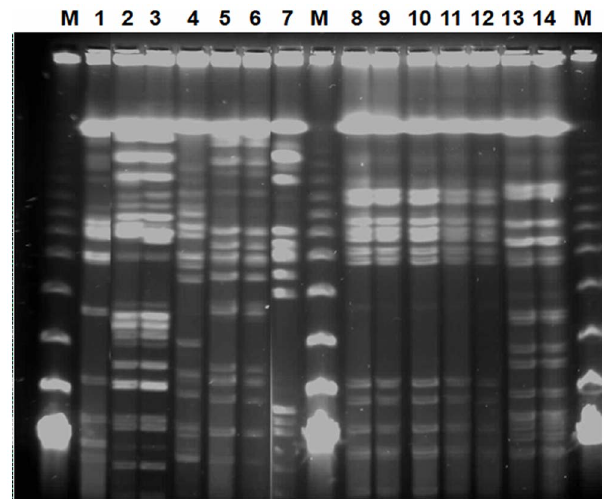
Figure 1. Representative PFGE fingerprint of differences between Salmonella isolates on 1 per cent agarose gel. M, lambda DNA marker; lane 1 to 14: O, P, Q, K, L, M, T, L1, L2, L3, L4, L5, L9 and L10.